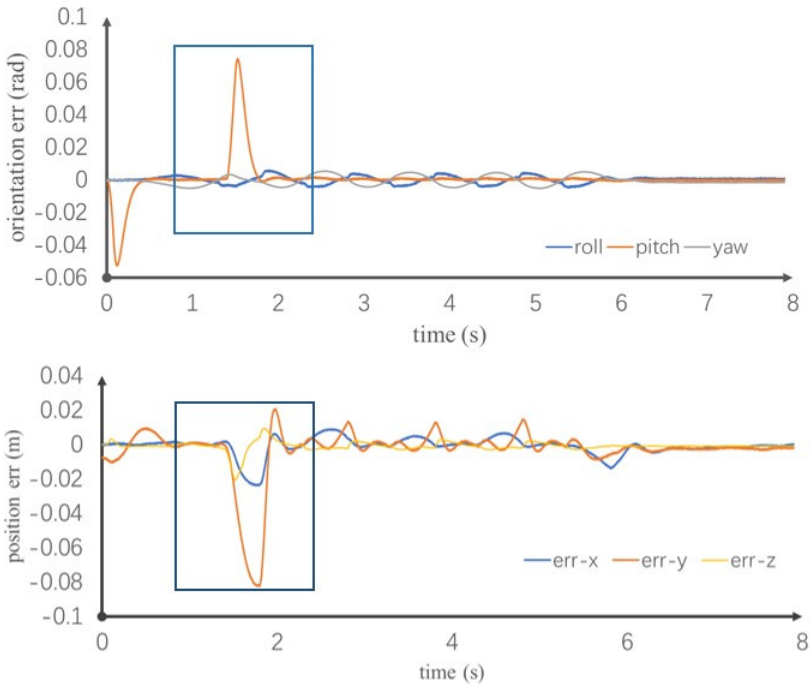
Figure 8. Center of mass (COM) tracking error and body posture error. Sensors 2020 , 20 , x FOR PEER REVIEW